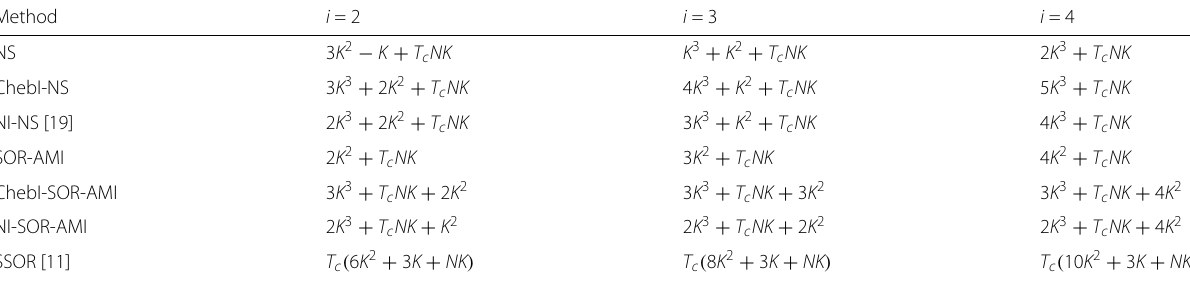
Table 1 Complexity analysis ( N number of BS antennas, K number of users, i iteration number, T c channel coherence